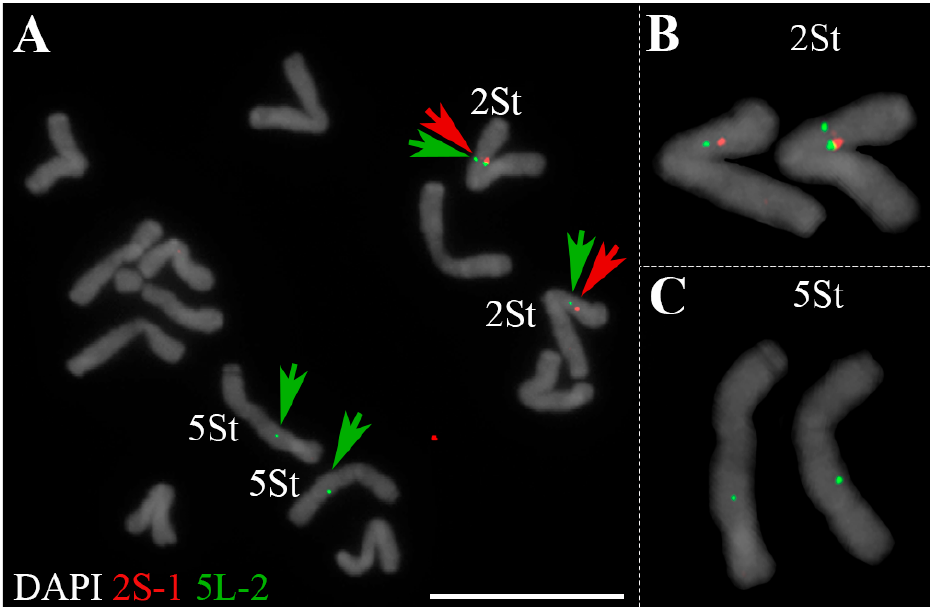
Figure 2. Single ‐ copy gene duplication in the chromosome of the P. libanotica . ( A ) Mitotic chromosomes of P. libanotica with single ‐ copy cDNA of 5L ‐ 2 (in green) and 2S ‐ 1 (in red). ( B ) cDNA FISH probes 5L ‐ 2 and 2S ‐ 1 located on the 2St_S chromosome. ( C ) cDNA FISH probes 5L ‐ 2 labeled the 5St chromosome. 2St and 5St were marked with red and green arrows, respectively. Scale bar equals 10 μ m.